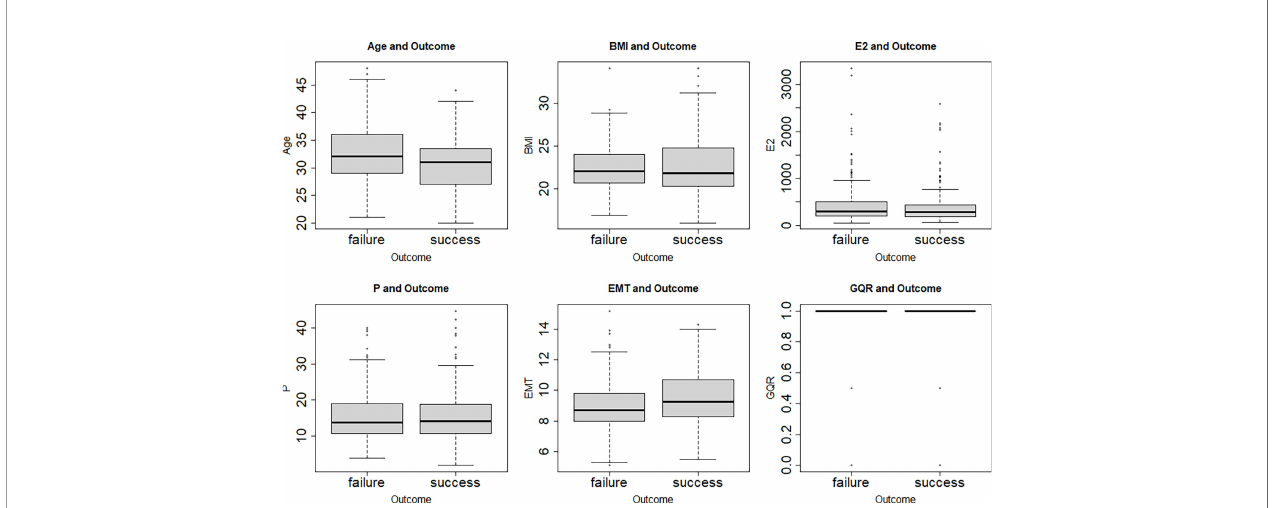
FIGURE 2 | Box plots of the age, BMI, E2, P, EMT and GQR in clinical pregnancy (success) and non-clinical pregnancy (failure) group. There were signi fi cant differences between the two groups in age (t = 3.70, P = 0.0002), EMT (t = -3.26, P = 0.001) and GQR (t = -3.84, P = 0.0001). BMI, body mass index; EMT, endometrial thickness on the day of progesterone treatment; GQR, good-quality embryo rate; E2, serum estradiol level on the day of embryo transfer; P, serum progesterone level on the day of embryo transfer; success: success of clinical pregnancy; failure: failure of clinical